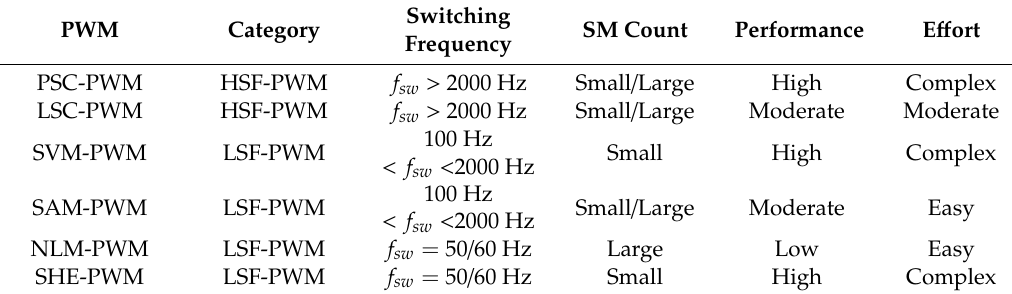
Table 2. Pulse width modulation techniques.